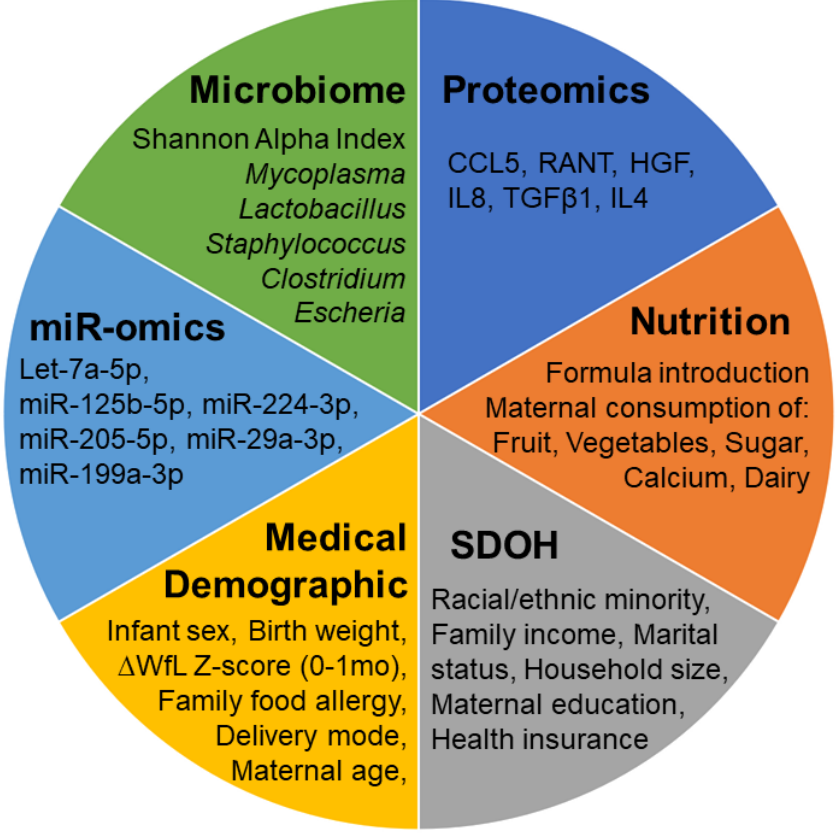
Figure 1. Conceptual framework for a multi-omics study of human milk factors involved in infant colic. The figure displays six categories of factors explored in this prospective cohort study of infant colic: (1) Milk proteins (cytokines), (2) Milk micro-ribonucleic acids (miR-omics), (3) Milk microbiome, (4) Medical/demographic traits, (5) Social determinants of health (SDOH), and (6) Nutritional components. Based on prior studies investigating these factors in nociception, gastrointestinal inflammation, and infant colic, we selected six features within each category for investigation.